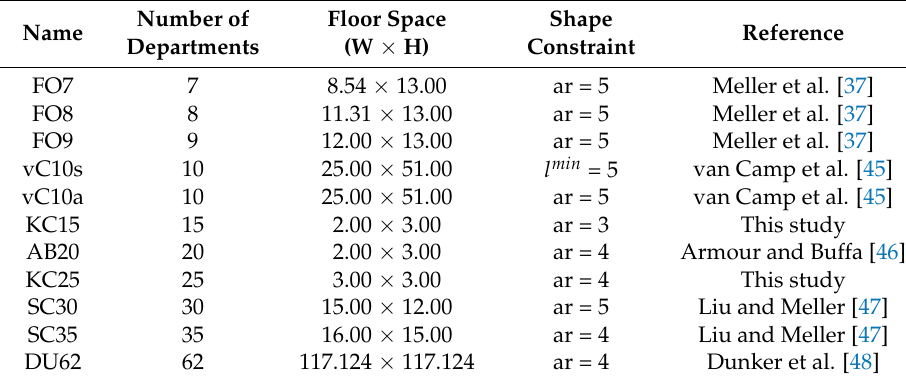
Table 3. The instance